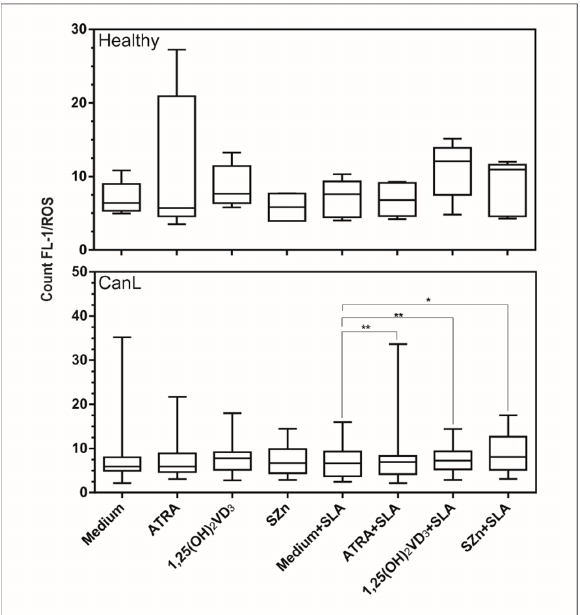
Figure 3. ROS production by spleen leukocyte cultures of the dogs with CanL and healthy dogs supplemented with nutrients. Spleen leukocytes from CanL ( n = 15) and healthy dogs ( n = 5) were cultured in the medium alone or with the addition of with ATRA, 1,25(OH) 2 VD 3 and SZn, both with and without SLA. ROS production in the cell cultures was determined by flow cytometry after 20 h. Bars represent the median and IQR with minimum and maximum error bars. Asterisks indicate a significant difference for the comparisons within the treatment (Wilcoxon test, * p < 0.05 and ** p < 0.01).